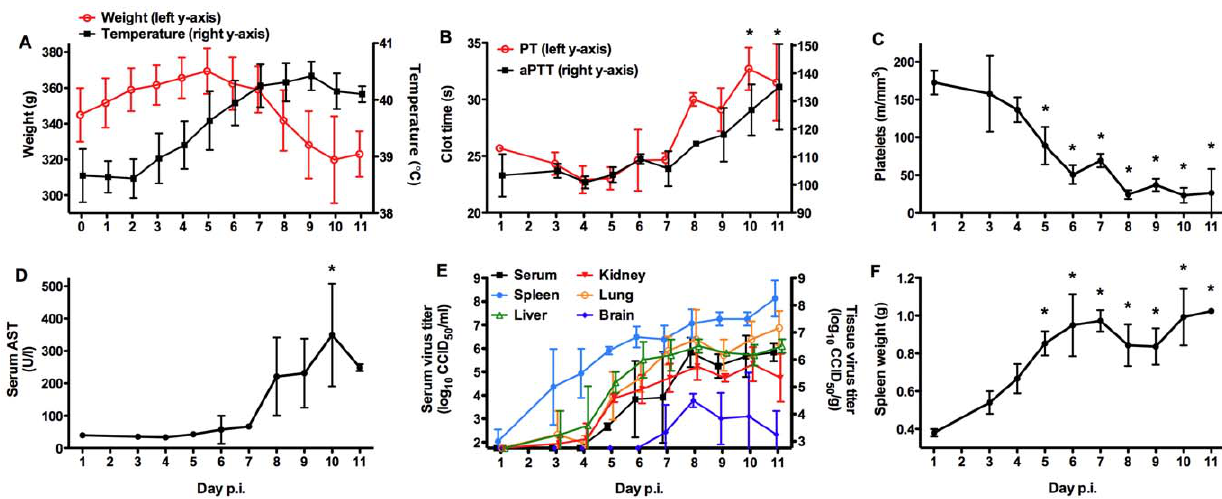
Figure 2. Natural history of disease caused by PICV infection in guinea pigs. Animals were challenged with 500 PFU of p19 PICV, (A) daily weights and temperatures were recorded, and groups of 3 were sacrificed on the indicated day p.i. for collection of blood and tissues for analysis of (B) PT and aPTT clot times, (C) PLT counts, (D) serum AST levels, (E) infectious serum and tissue virus titers, and (F) splenomegaly during the course of infection. Due to a technical problem, PT clot times were not detected in two of three animals on day 1. * P , 0.05 compared to day 1 p.i. (day 3 p.i. for PT).